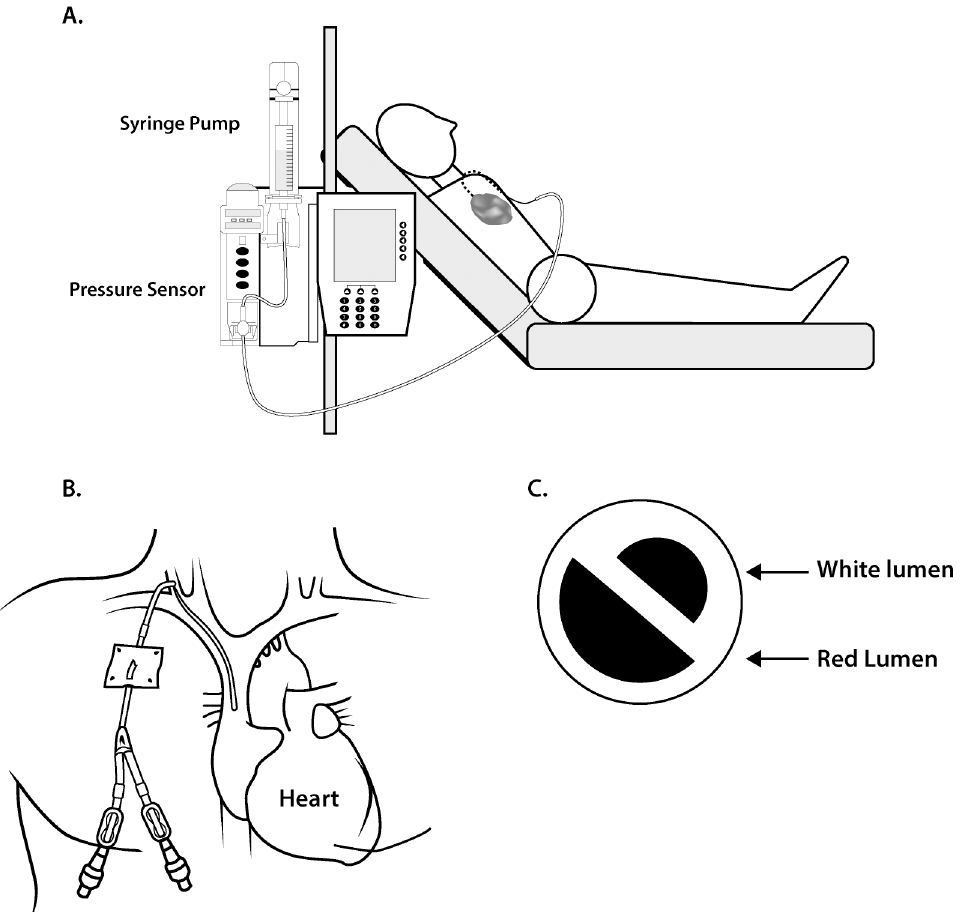
Fig 2. Patient positioning during CRM. (A) Resistance measurements were performed with the participant lying at an angle of approximately 45°. The pressure sensor was placed below the estimated height of the participant ’ s right atrium. The relative heights and positions of the patient and pump were not altered between or during measurements. (B) Illustration of a tunneled external CVC. (C) Diagram of the catheter cross-section showing the different luminal